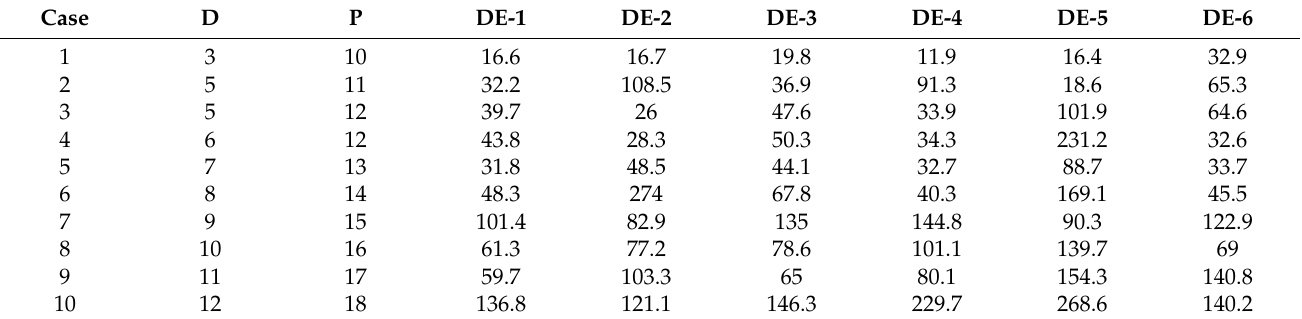
Table 16. Average number of generations for six discrete DE algorithms with population size NP = 30; D r = P r =0.1.